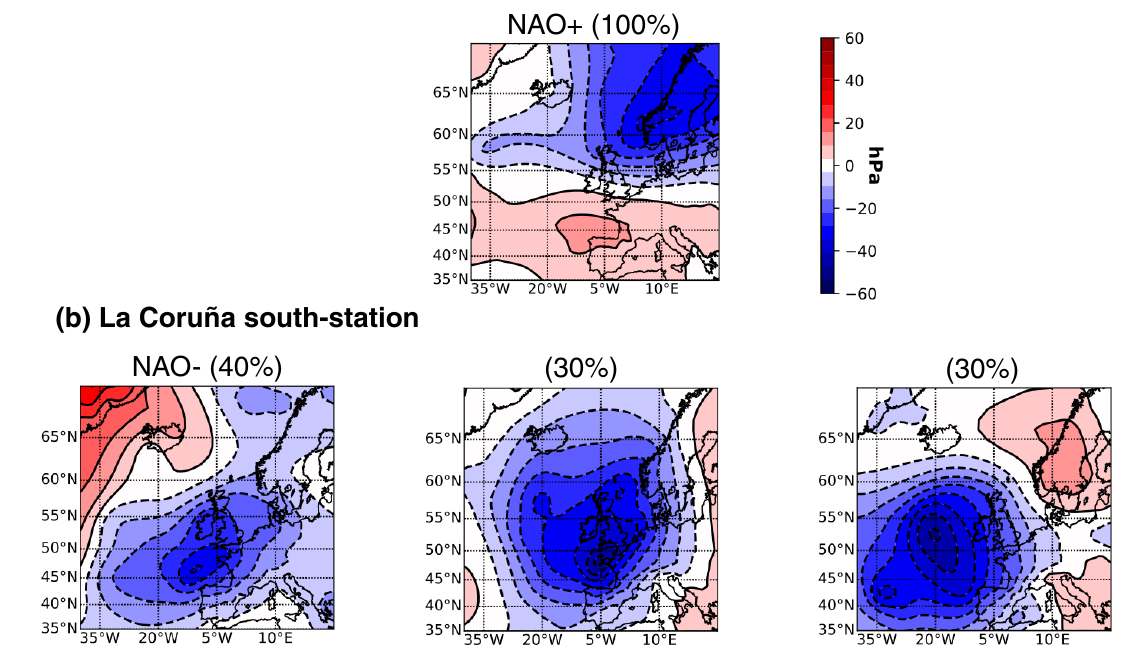
Figure 7. Typical weather situations (SLP anomalies) driving the 15 highest storm surges recorded at ( a ) Tregde and ( b ) La Coruña. SLP anomalies are computed from 20CR, retrieving the average value over the period 1836- 2015. See Supplementary Fig. S6 for the corresponding SLP and wind